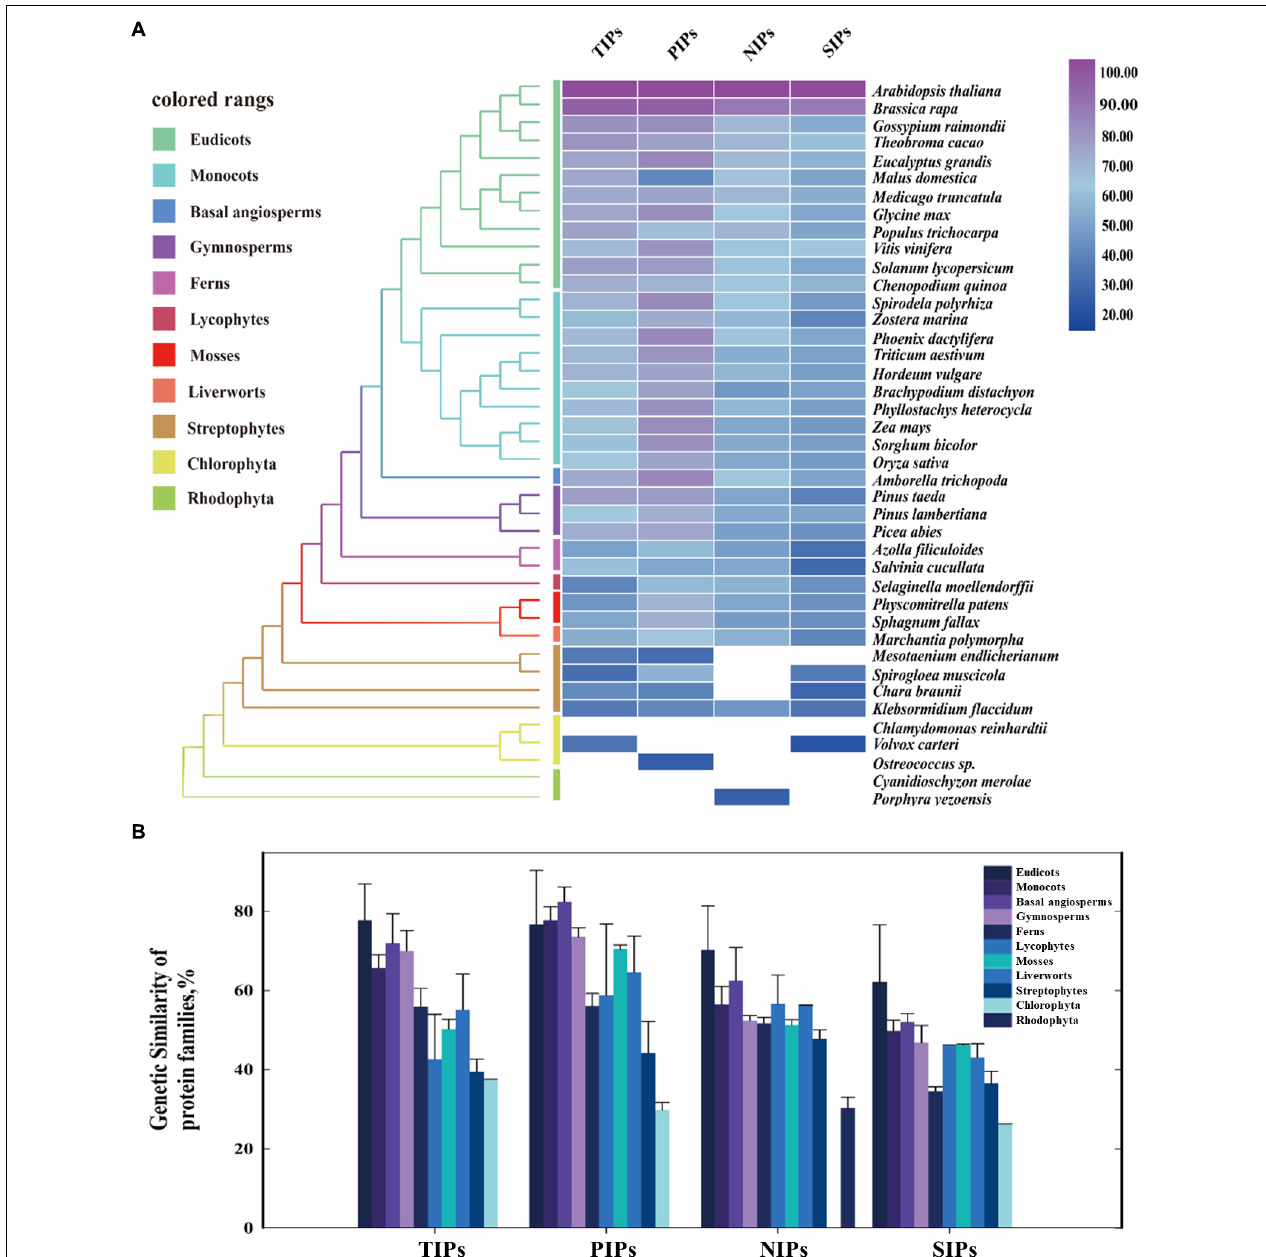
FIGURE 1 | Evolutionary similarity of AQP protein families of the major clades in land plants and algal species. (A) The protein similarity heat map for the evolution of AQP families. A simplified tree was shown and color coded to the main clades of land plants and algal species. Colored rectangles indicate protein sequence similarity from 20% (blue) to 100% (purple). White squares indicate no proteins satisfied the selection criteria. (B) Comparative genetic similarity analysis was conducted with protein sequences of 42 plants and algal species that span from rhodophyta to eudicots. Colored rectangles indicate different plant groups. Candidate protein sequences were selected using BLASTP (NCBI) searches, and the results were filtered with an E-value threshold of 10 − 5 and sequence coverage of